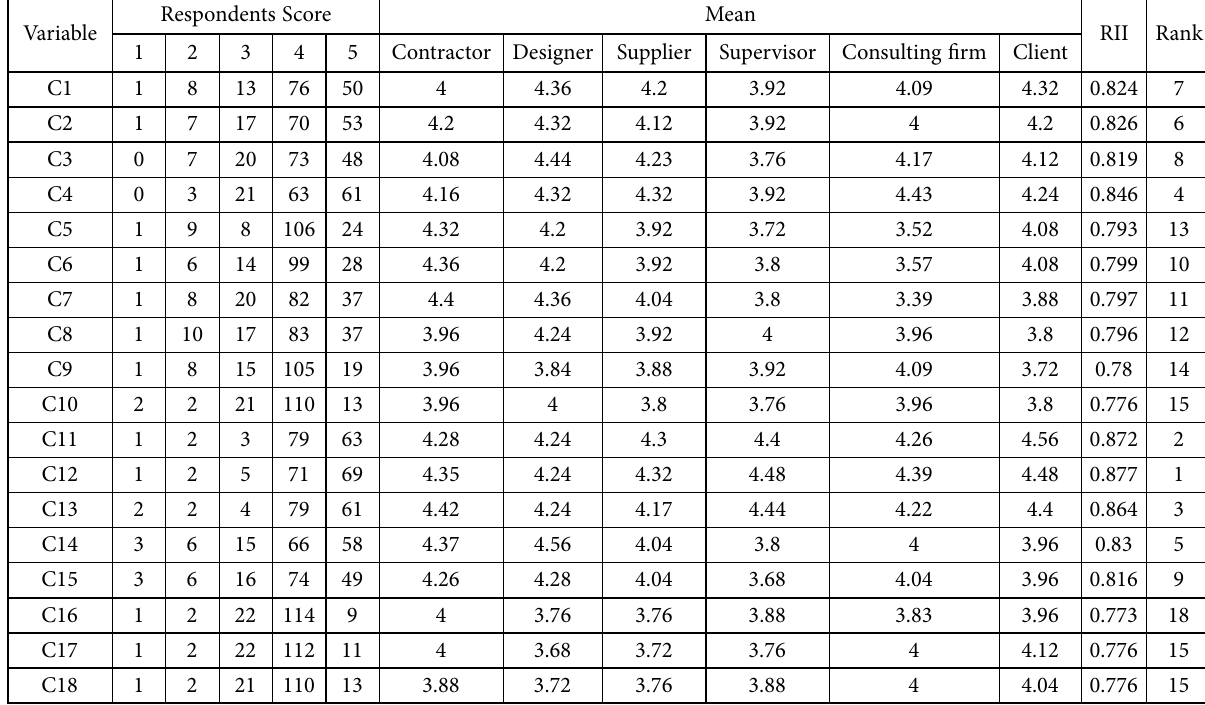
Table 3. RII and ranking of 18